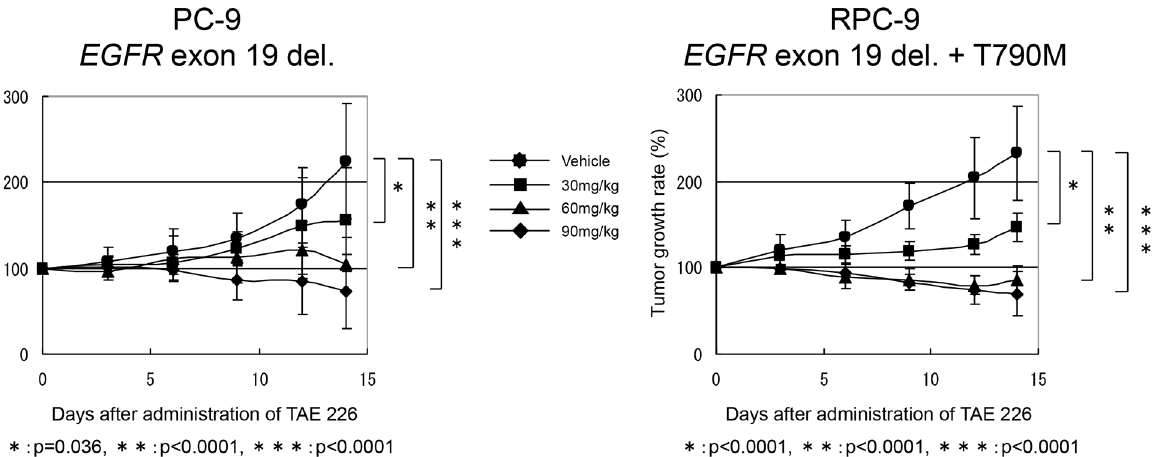
Fig 3. The anti-tumor effect of TAE226 in xenograft models. The oral administration of TAE226 for 14 days significantly inhibited the tumor growth of the subcutaneously inoculated mice xenografts with PC-9 (exon19 deletion) or RPC-9 (exon19 deletion and T790M mutation) at every dose (30, 60 and 90 mg/kg). In addition, TAE226 showed the similar anti-tumor effect on both xenograft models irrespective of the presence of EGFR T790M